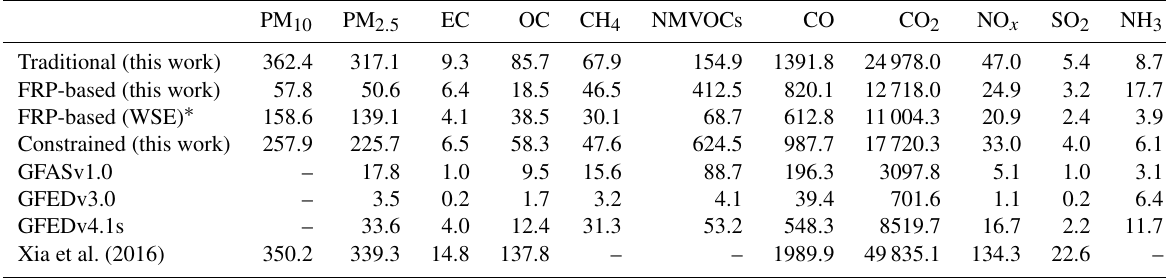
Table 3. OBB emissions in the YRD derived from this work and other studies in 2010 (unit: Gg).